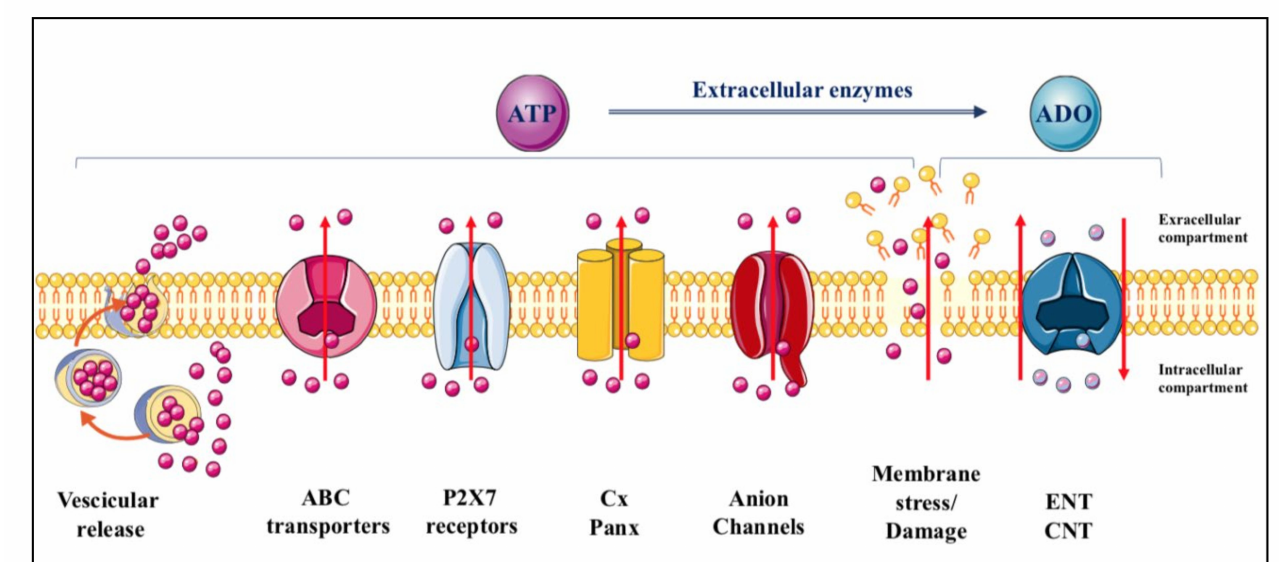
Figure 1. Mechanisms of purine release. ATP is released from cells in physiological conditions through multiple ways including vesicular exocytosis, connexin/pannexin (Cx/Panx) hemichannels, facilitated diffusion by nucleotide-specific ATP-binding cassette (ABC) transporters, and multiple organic anion transporters. In contrast, while most of the adenosine is formed from the nucleotide metabolism at extracellular level, the principal mechanism of adenosine efflux from cells is assured, under cell stress conditions, by carriers identified as equilibrative (ENT) and concentrative (CNT) nucleoside transporters. The former are bidirectional carriers, the direction of transport depending on the nucleoside concentration gradient across the plasma membrane, while the latter are Na + - dependent, being the nucleoside transport coupled to that of the sodium ion and independent of the nucleoside concentration gradient [27]. Additional transporters such as organic anion and cation transporters and ABC transporter proteins, have been implicated only as carriers of nucleoside- derived drugs, particularly those used as antiviral drugs